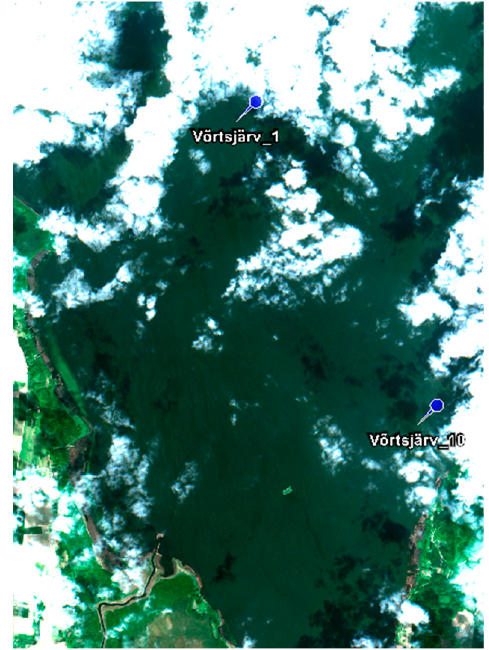
Figure A9. S2 MSI image of Võrtsjärv from 20th of May 2016.